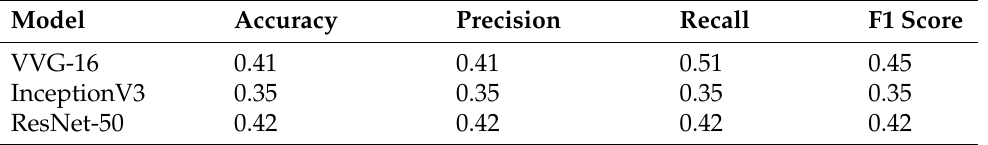
Table 16. Results using pre-trained deep learning models on the original dataset.